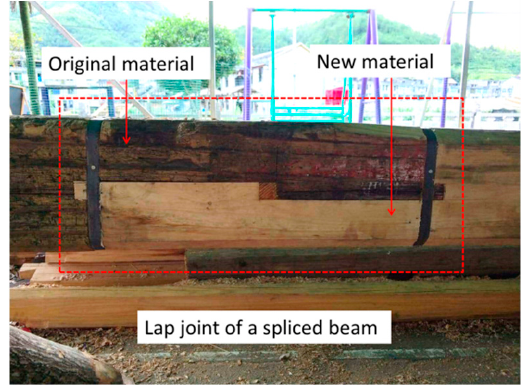
Figure 2. A lap joint of a spliced beam.